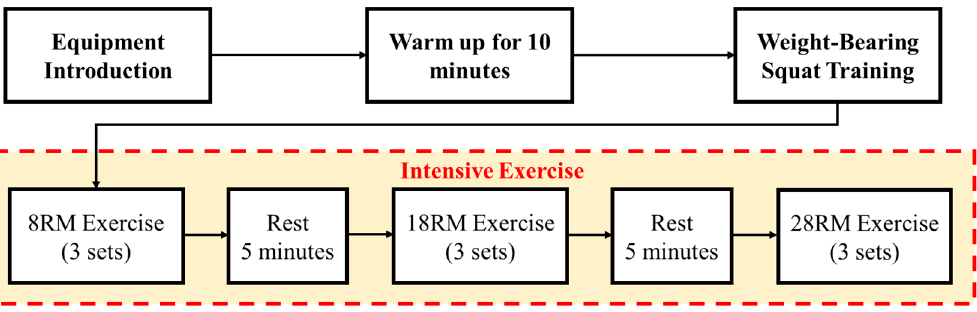
Figure 2. Flowchart of the intensive exercise training.